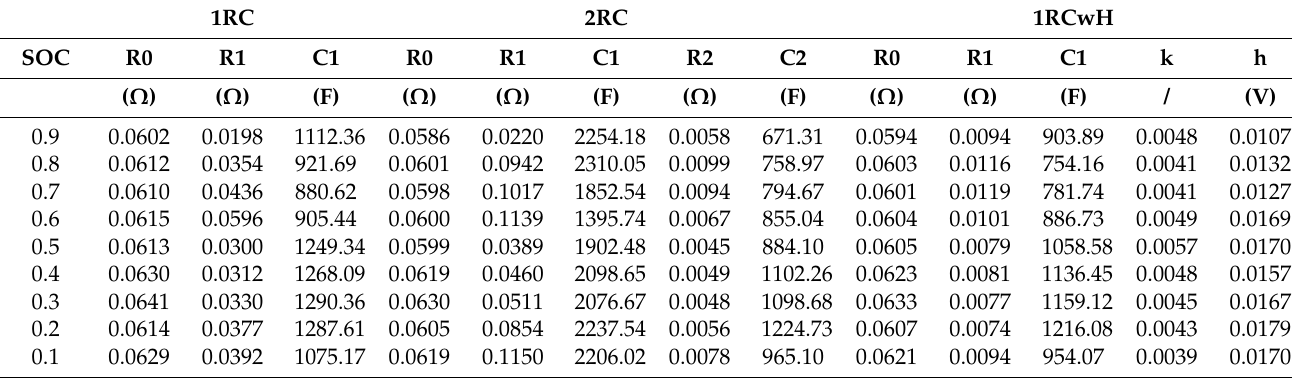
Table 7. Model parameters obtained from HPPC data fitting in MATLAB for the NMC cell.